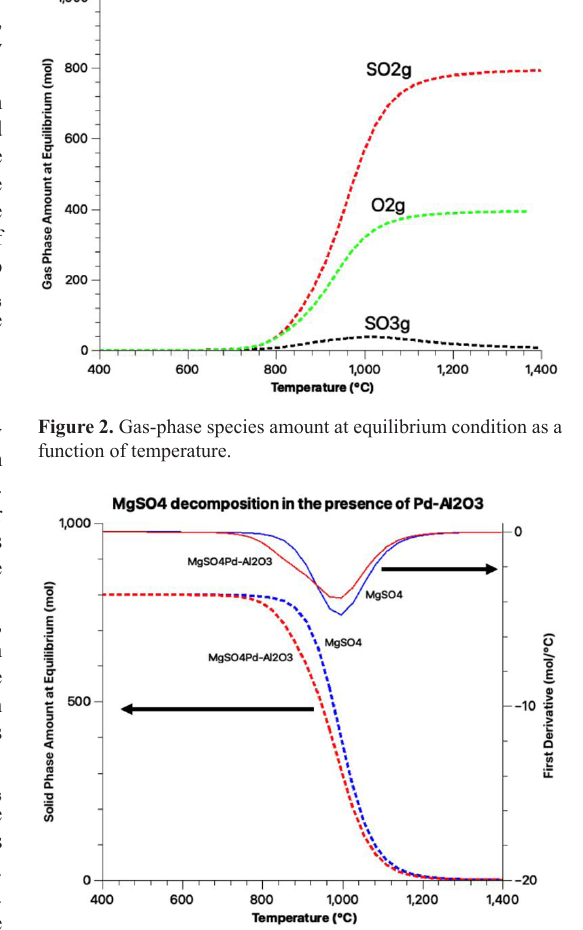
behavior with or without 20%(wt./wt.) of Pd/ Figure 3. MgSO 4 Al O material depicted by means of solid-phase species amount 2 3 at equilibrium as a function of